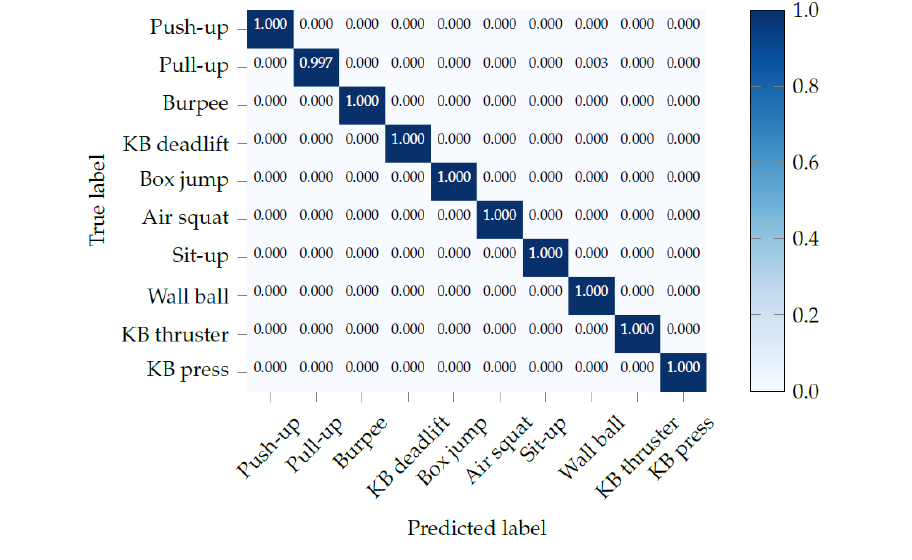
Figure 6. Confusion matrix of exercise recognition using all sensors from both